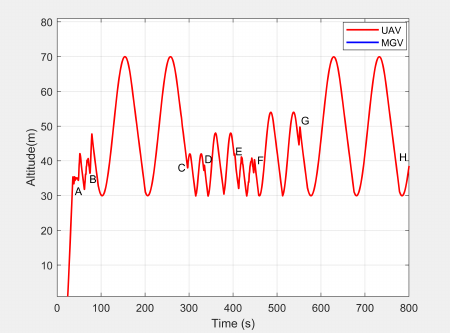
Figure 14. Altitude of the UAV’s planned path when following the MGV while moving at a varying ve-